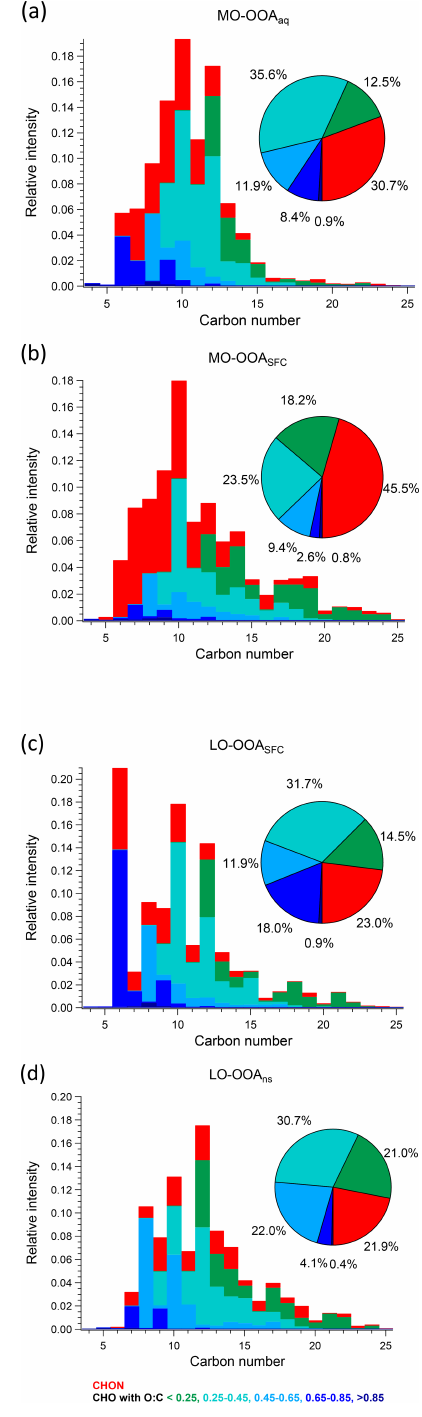
Figure 7. Carbon number distribution plots of four OOA fac- tors: (a) MO-OOA aq , (b) MO-OOA SFC , (c) LO-OOA SFC , and (d) LO-OOA ns , coloured by C x H y O z N 1–2 (red), and five dif- ferent C x H y O z categories (green to blue) based on H:C ratio (H:C < 1.1, 1.1 < H:C < 1.3, 1.3 < H:C < 1.5, 1.5 < H:C < 1.7 and H:C > 1.7). Each distribution is normalised such that its sum is 1.